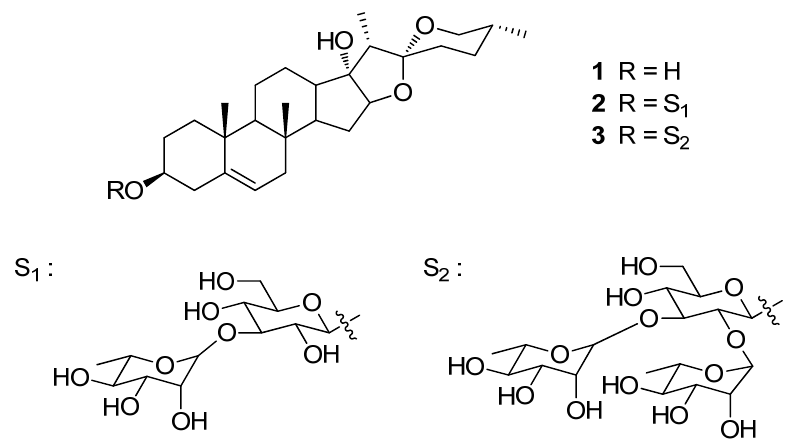
Figure 5. Chemical structures of pennogenin ( 1 ), mannioside A ( 2 ), and spiroconazol A ( 3 ) isolated from D. bulbifera L. var. sativa .